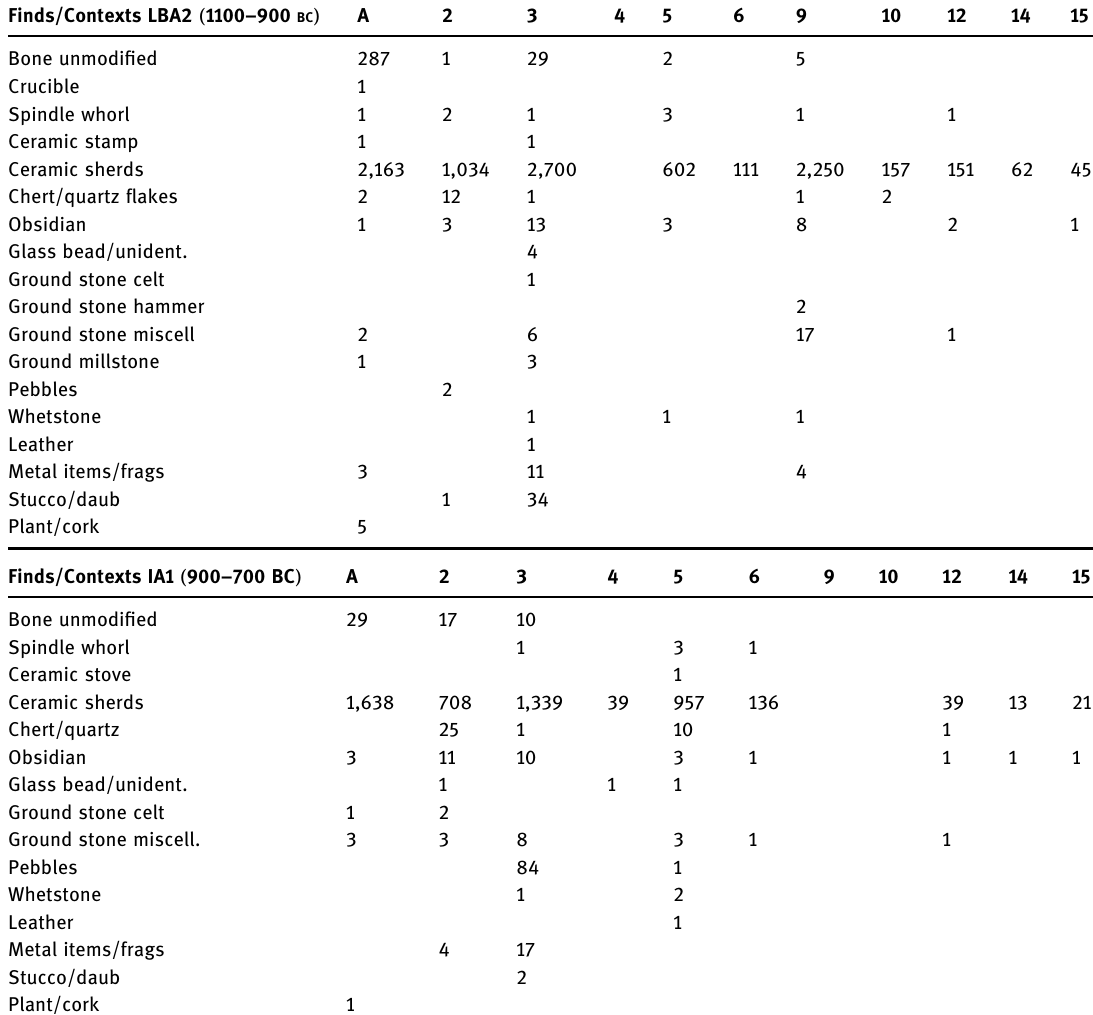
Table 2: Duos Nuraghes Late Bronze and Iron Age fi nds from Tower A and buildings 2 – 15 ( data from Webster, 2001, pp. 50 – 51, table 4.1, pp. 77 – 78, table 4.2